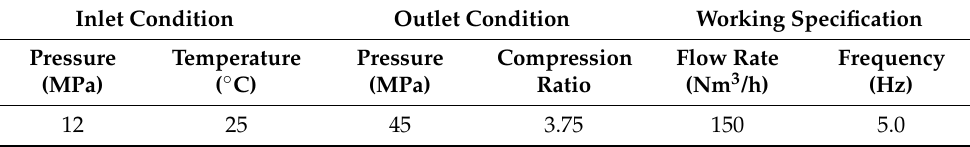
Figure 2. Physical structure of hydrogen compressor. Table 1. Requirements for designing the hydrogen compressor in this study.